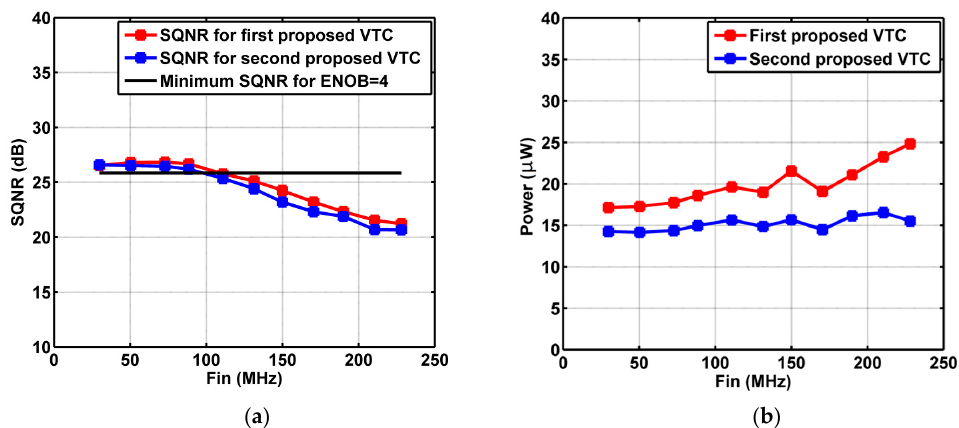
Figure 11. ( a ) Signal-to-quantization noise ratio (SQNR) for different input frequencies, and ( b ) power consumption for different input frequencies.